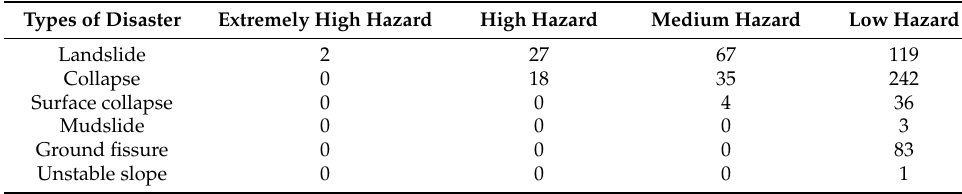
Table 5. Statistical table of disaster intensity level in different types of